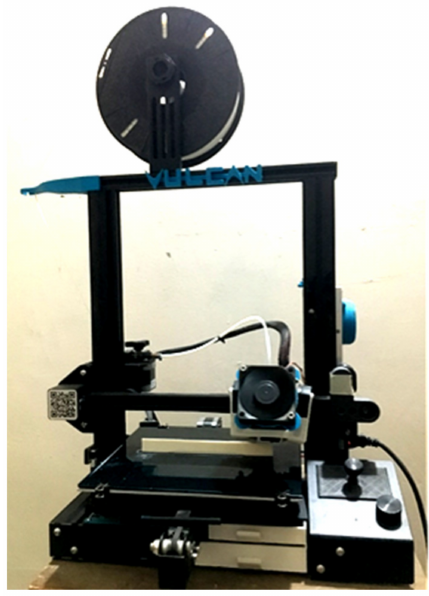
Figure 5. “Creality Ender—3”